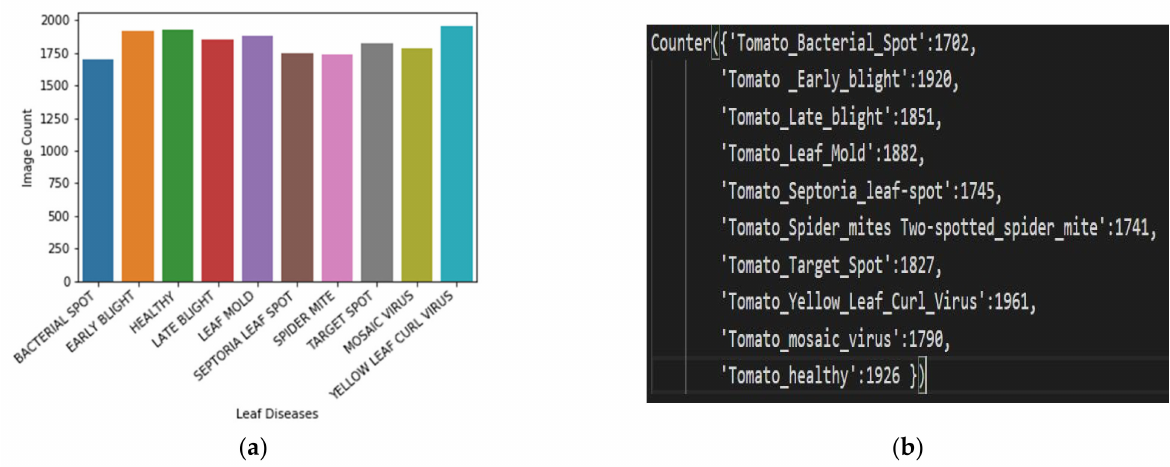
Figure 2. ( a ) Graph of Total Training Data. ( b ) The part of the code for tomato leaf disease detection using CNN